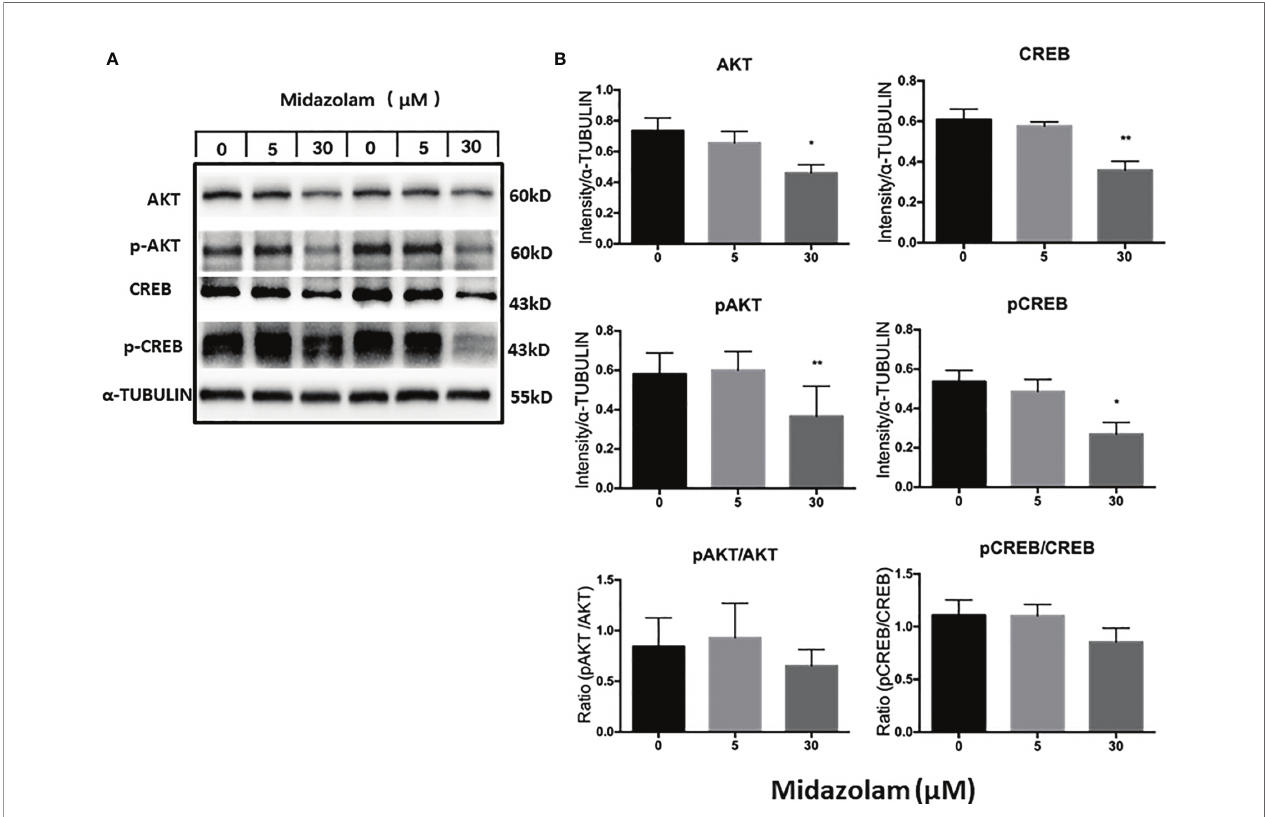
FIGURE 8 | Effects of midazolam on the expressions of AKT-CREB signaling molecules. (A) Stem Leydig cells were induced to differentiate into Leydig cells in the presence of 5 or 30 m M of midazolam for 21 days. Expressions of AKT, CREB, and their phosphorylated forms were analyzed by Western blotting with a -tubulin as an internal control. These Western blotting bands were from two individual experiments. (B) Quanti fi cation of the Western blotting results. Data are expressed as mean ± SEM of three experiments. Signi fi cantly different from the control groups at *p < 0.05 or